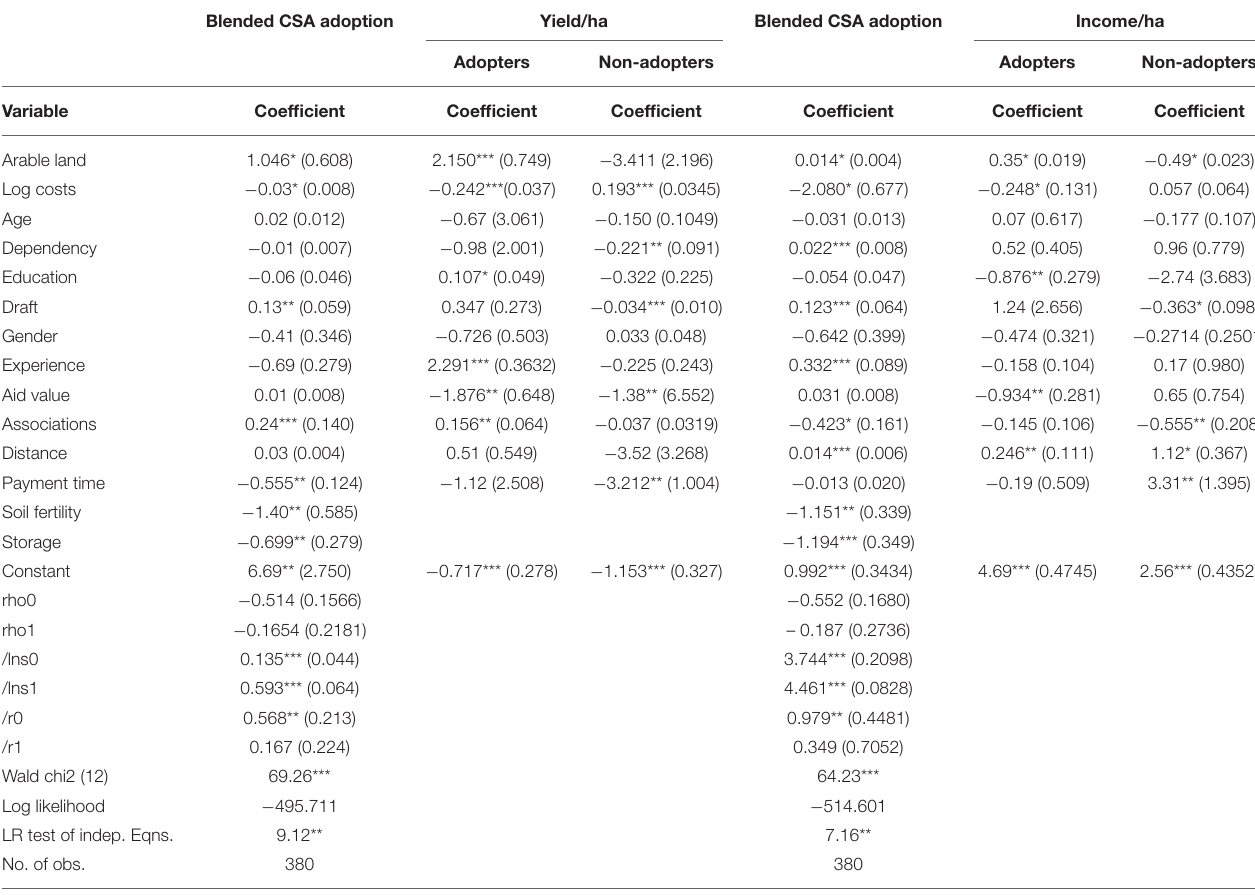
TABLE 3 | Full information maximum likelihood estimates of productivity and income. Blended CSA